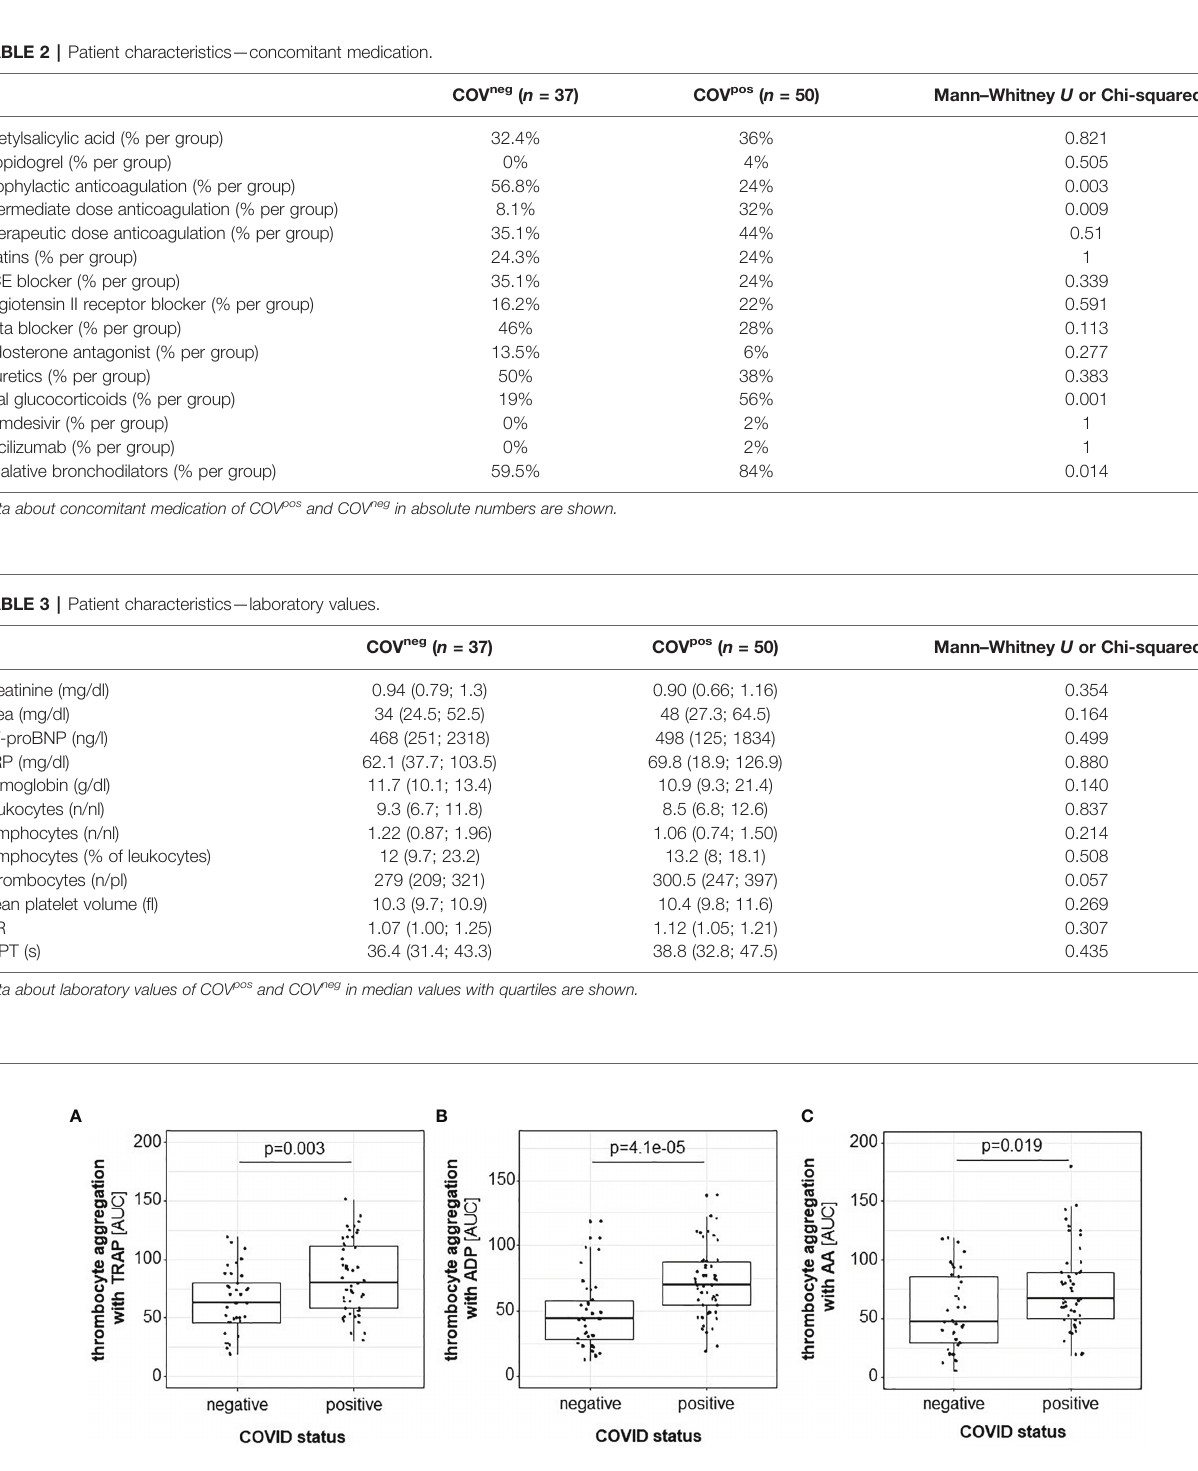
FIGURE 1 | Platelet aggregation induced by TRAP (A) , ADP (B) , and AA (C) , as assessed by MEA, is higher in COV pos ( n = 50) than in COV neg ( n = 37) patients.